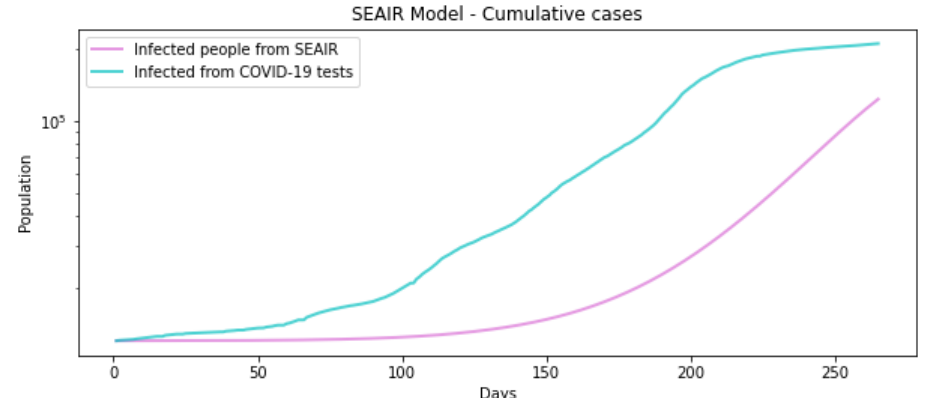
Figure 17. Comparison of cumulative infected people between SEAIR model and COVID-19 tests in Denmark’s second wave after applying the best vaccination plan found.